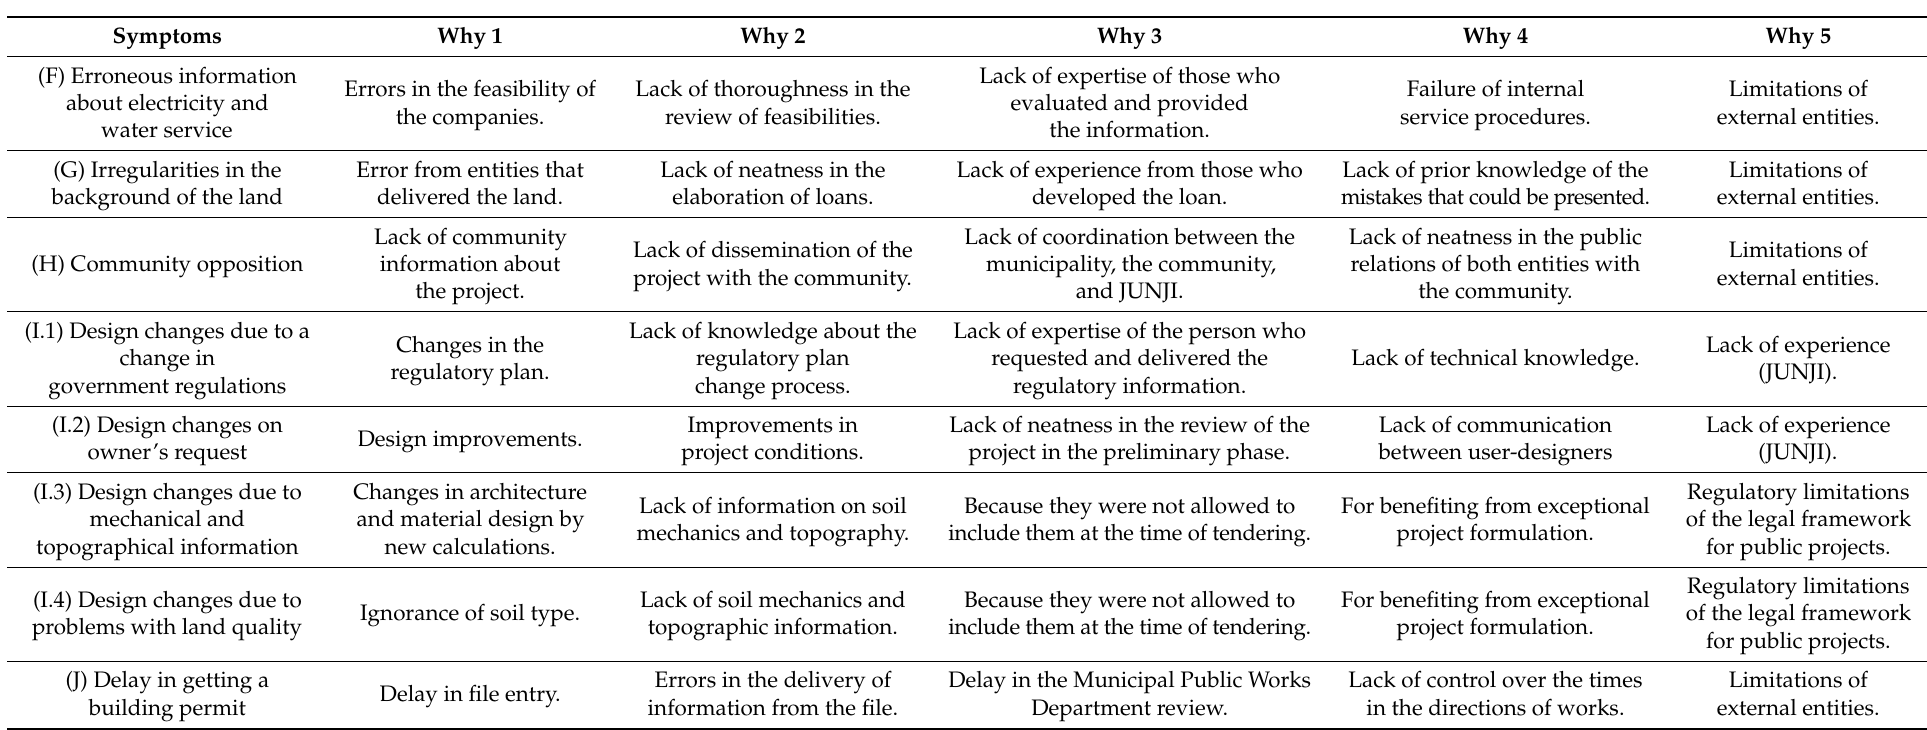
Table 5. Root-cause analysis results of case study